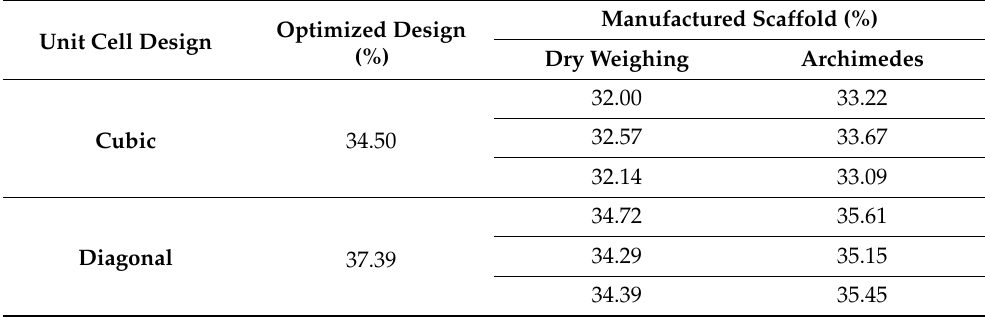
Table 4. Comparison in structure relative densities between the CAD file and manufactured